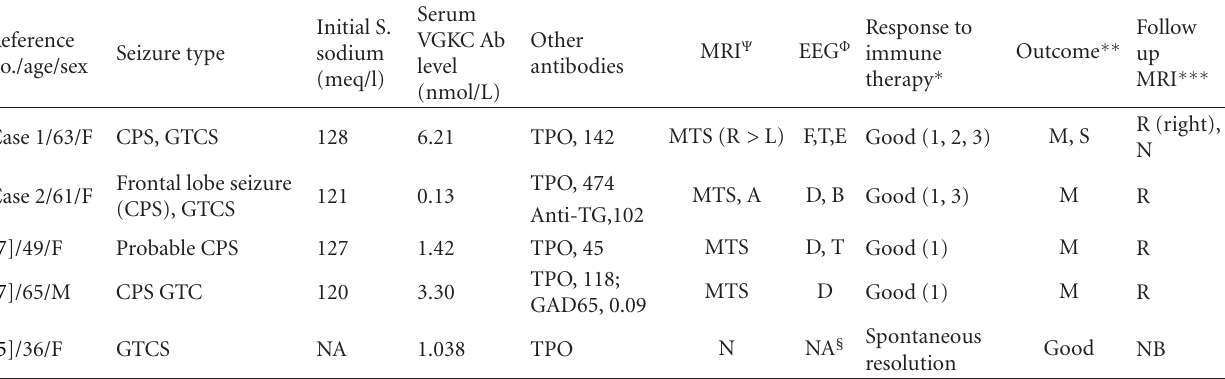
Table 1: Comparison of reported cases of subacute encephalitis associated with voltagegated potassium channel antibody (VGKCAb) and antithyroperoxidase